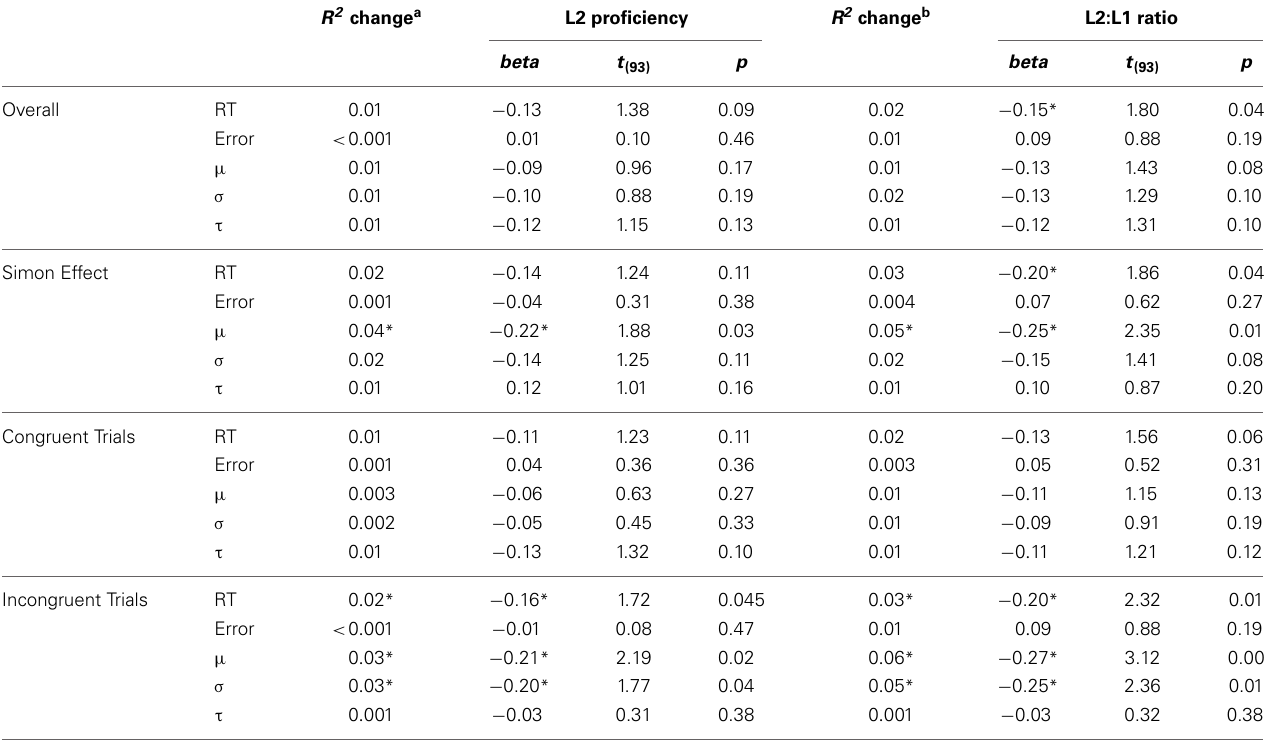
Table 4 | The findings of regression analyses for participants’ performance in the Simon task after partialling out the participants’ age (i.e., cognitive maturation).